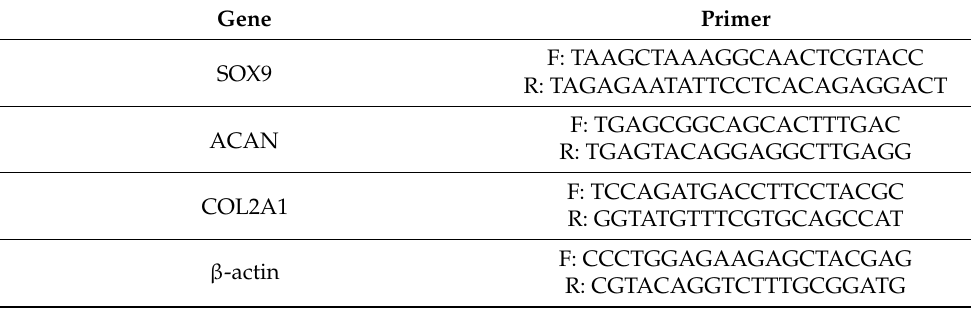
Table 1. Gene-specific primers for real-time